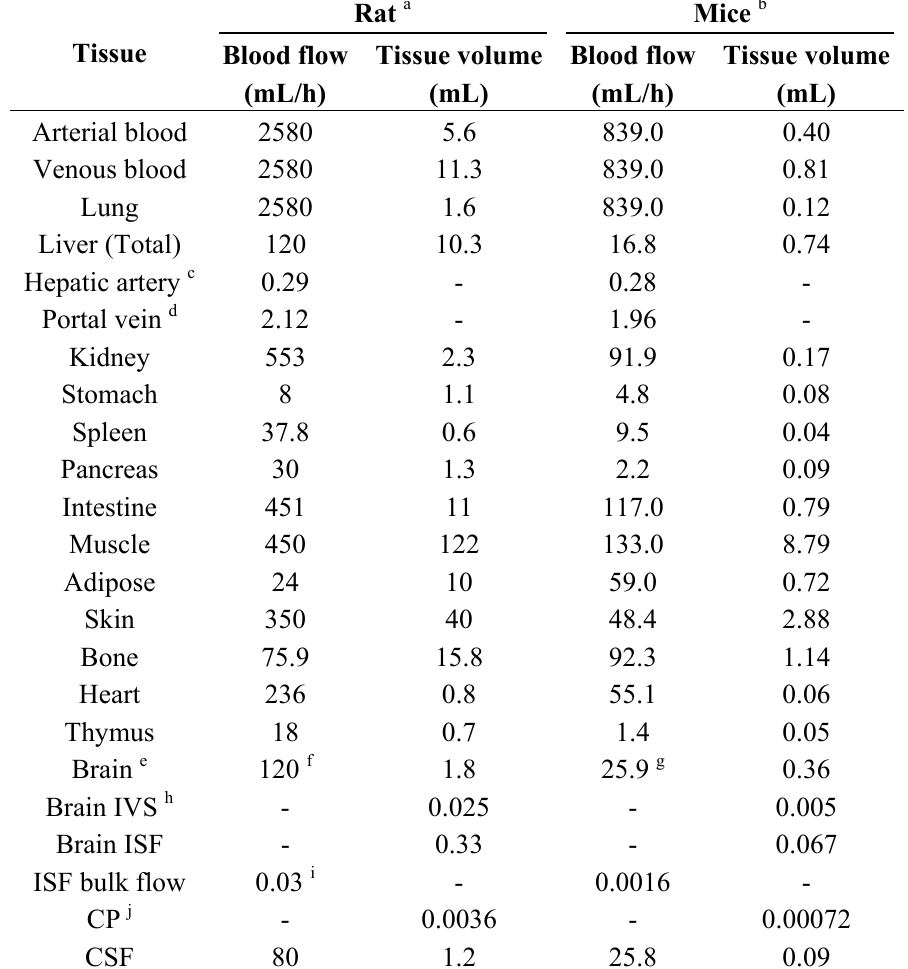
Table 1. Physiologically based pharmacokinetic (PBPK) model parameters for rats and